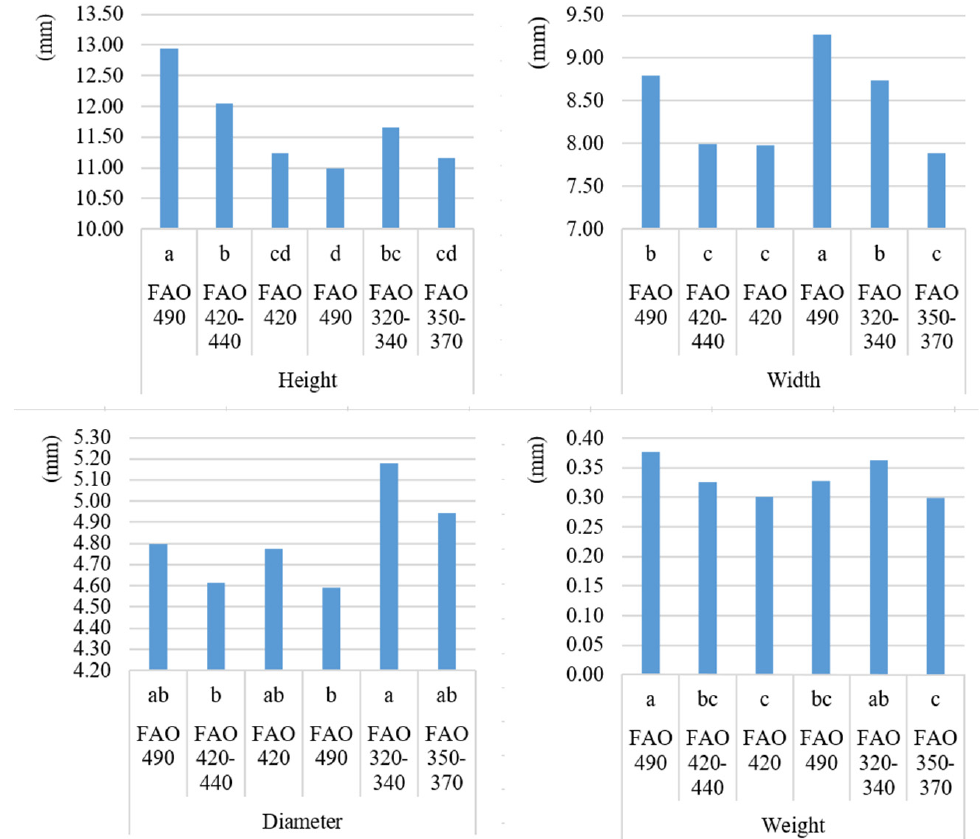
Figure 2. Results of comparing the seed parameter differences of hybrids. Notes: Treatments with the same letter are not significantly different. Table 2. Variance analysis of productivity